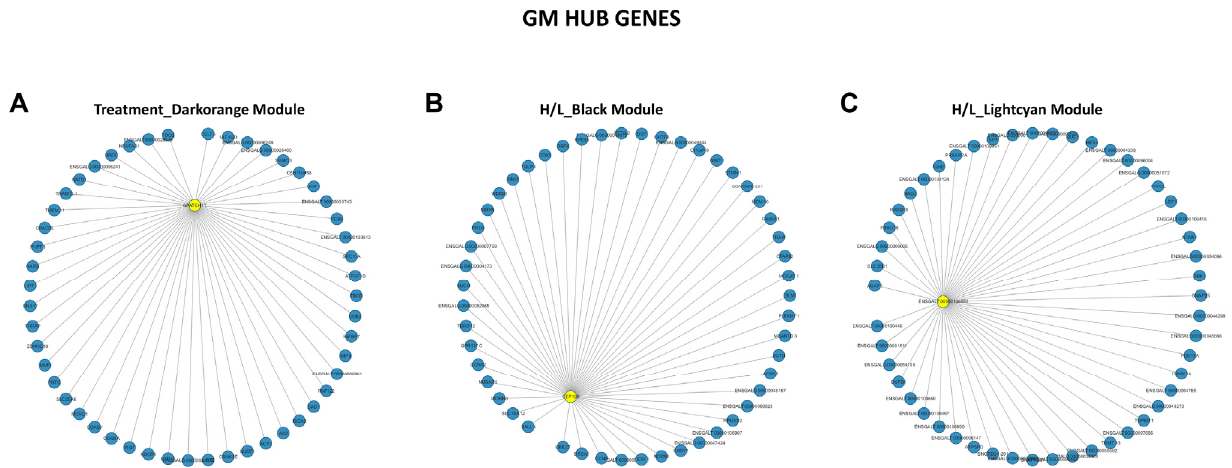
Figure 7. Co-expression network of hub genes in GM chickens: ( A ) Filtered co-expression network treatment darkorange module. ( B ) Filtered co-expression network H/L black module. ( C ) Filtered co-expression network H/L lightcyan module.